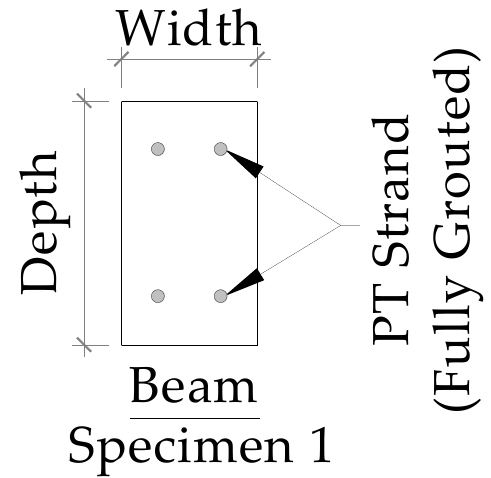
Figure 11. PT strand fully grouted.